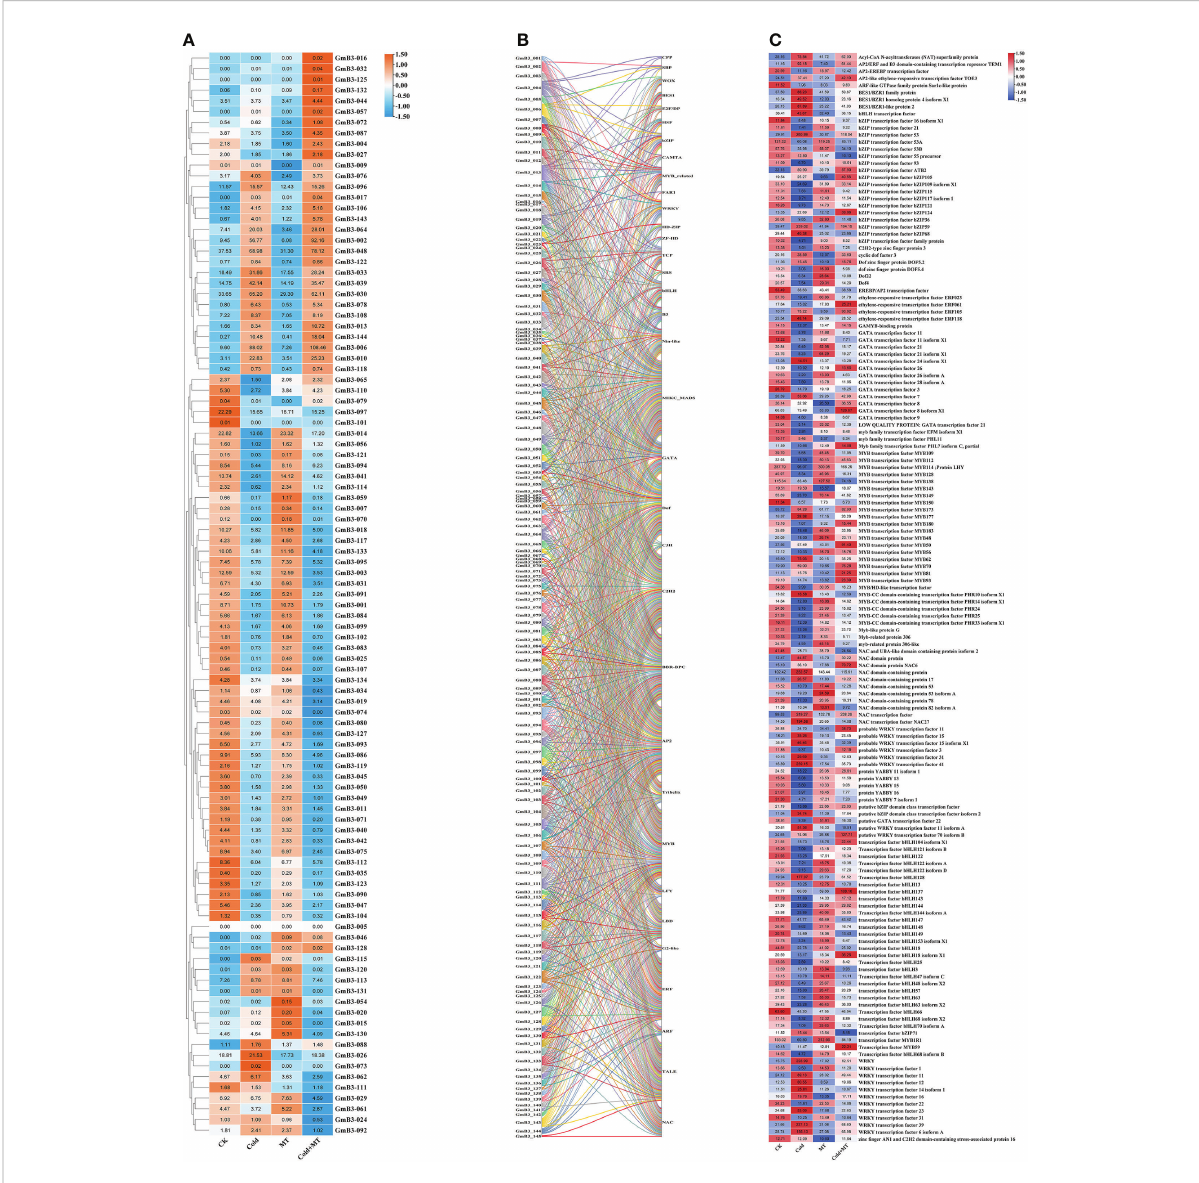
FIGURE 9 Network analysis of soybean B3 genes and transcription factors. (A) Expression level of B3 genes under different treatments. (B) Relationship between the B3 gene and other transcription factors. (C) Expression level of other transcription factors under different treatments. Different colors represent different GmB3